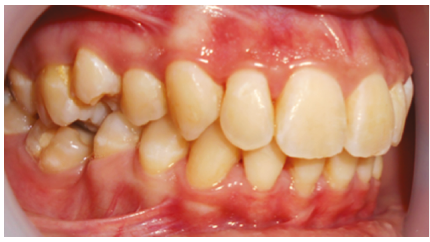
Figure 6: Final right side view 2 years post treatment.